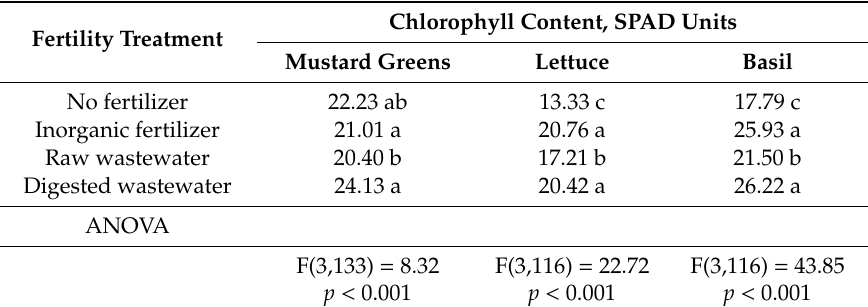
Table 2. Mean chlorophyll content (SPAD values) averaged across 6 weeks for mustard greens, lettuce, and basil grown with di ff erent fertility treatments in a greenhouse in St. Paul, Minnesota in 2018. Values within the same column with different letters are significantly different (Tukey’s HSD, α = 0.05).